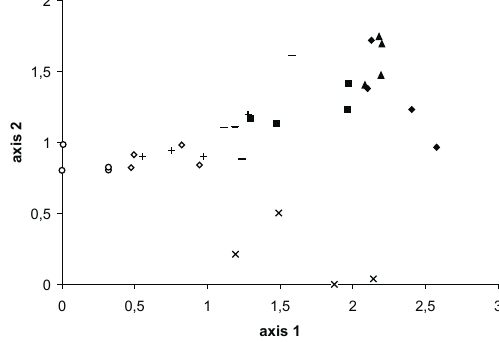
(32 grids in 8 sites).  Pikku-Malla,  Iso-